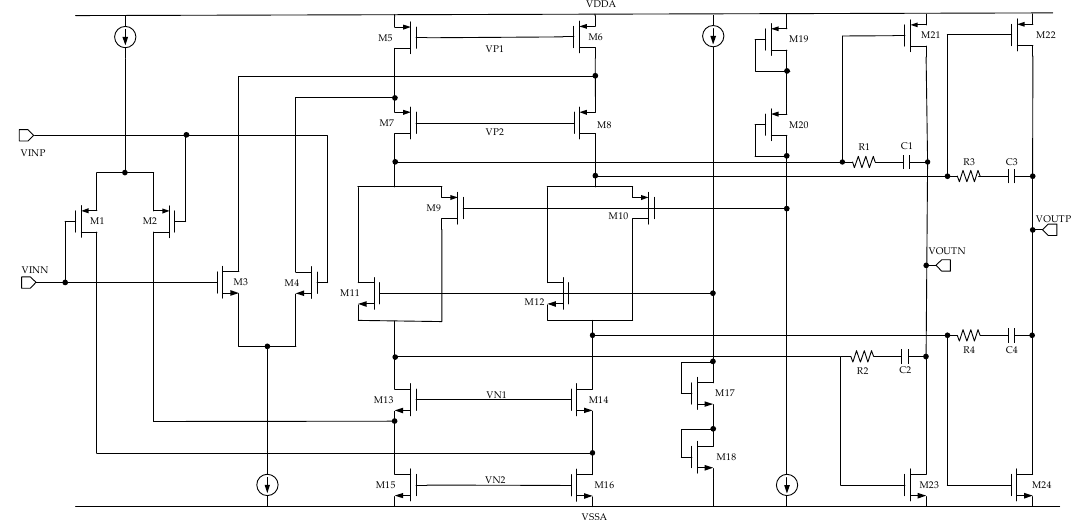
Figure 6. First-stage integrator op amp.